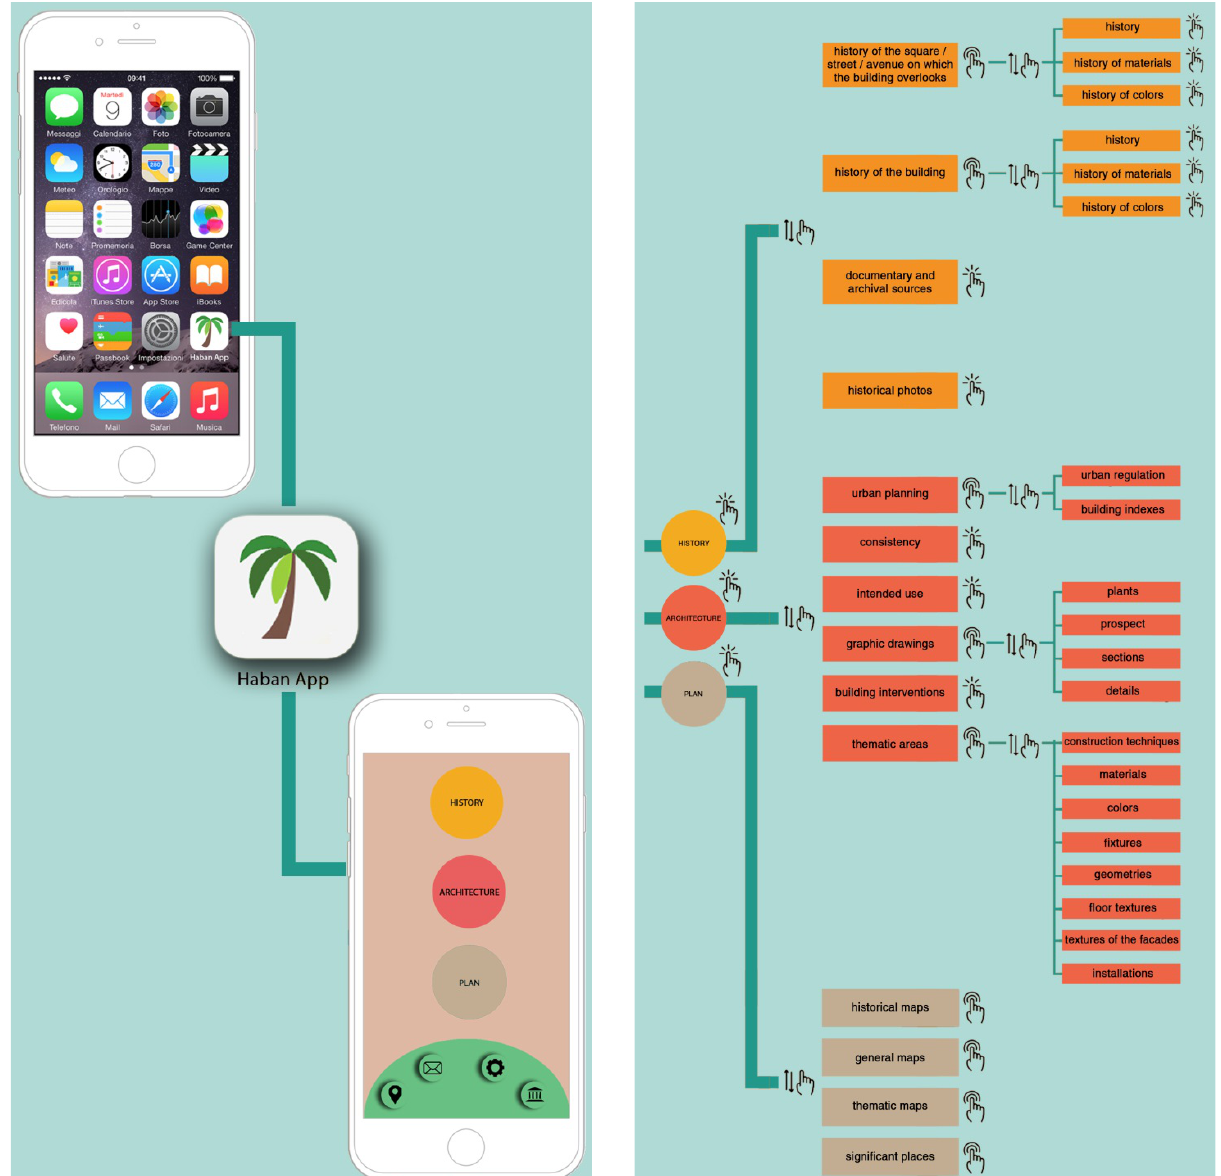
Figure 4. Example of a digital mockup -